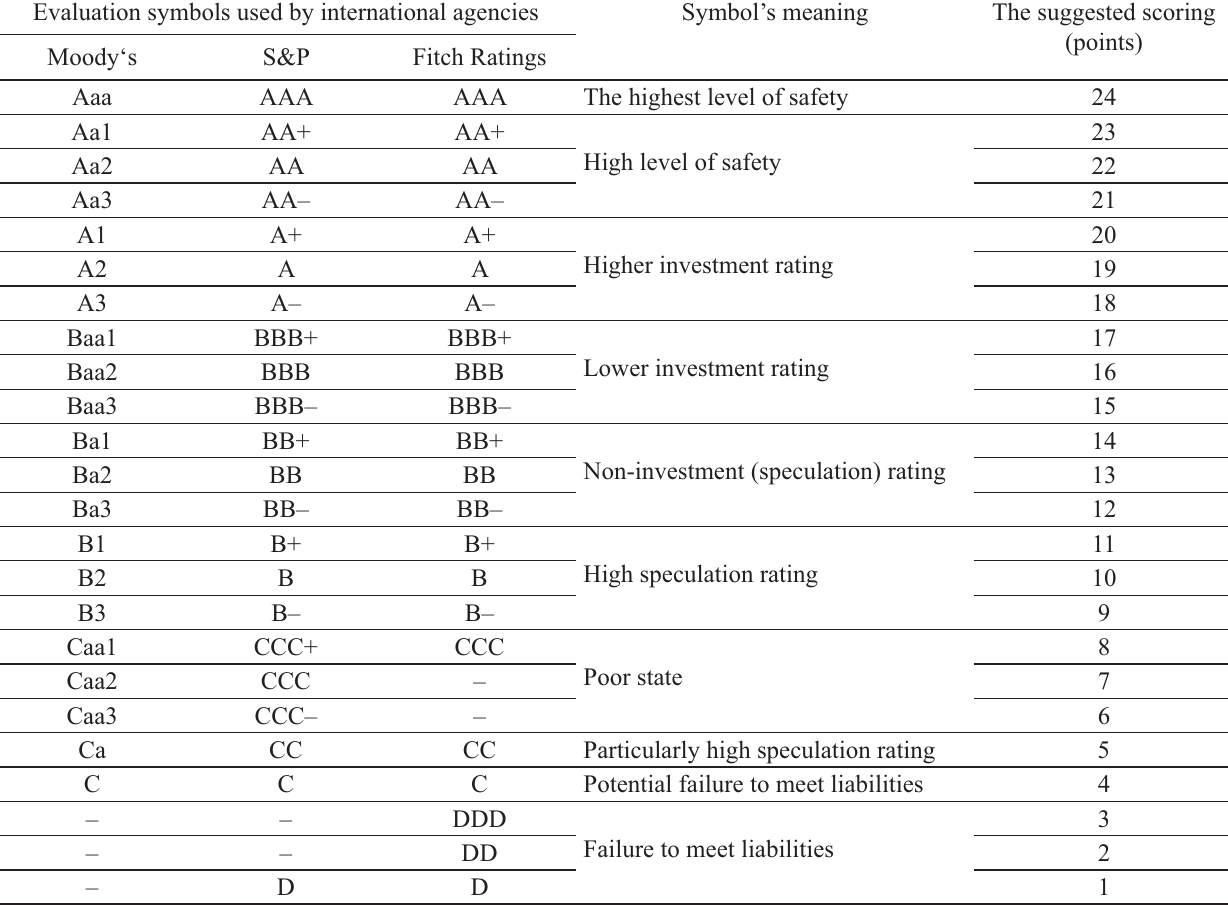
Table 3 . Evaluation of banks based on long-term debts according to international agencies’ rating Evaluation symbols used by international agencies